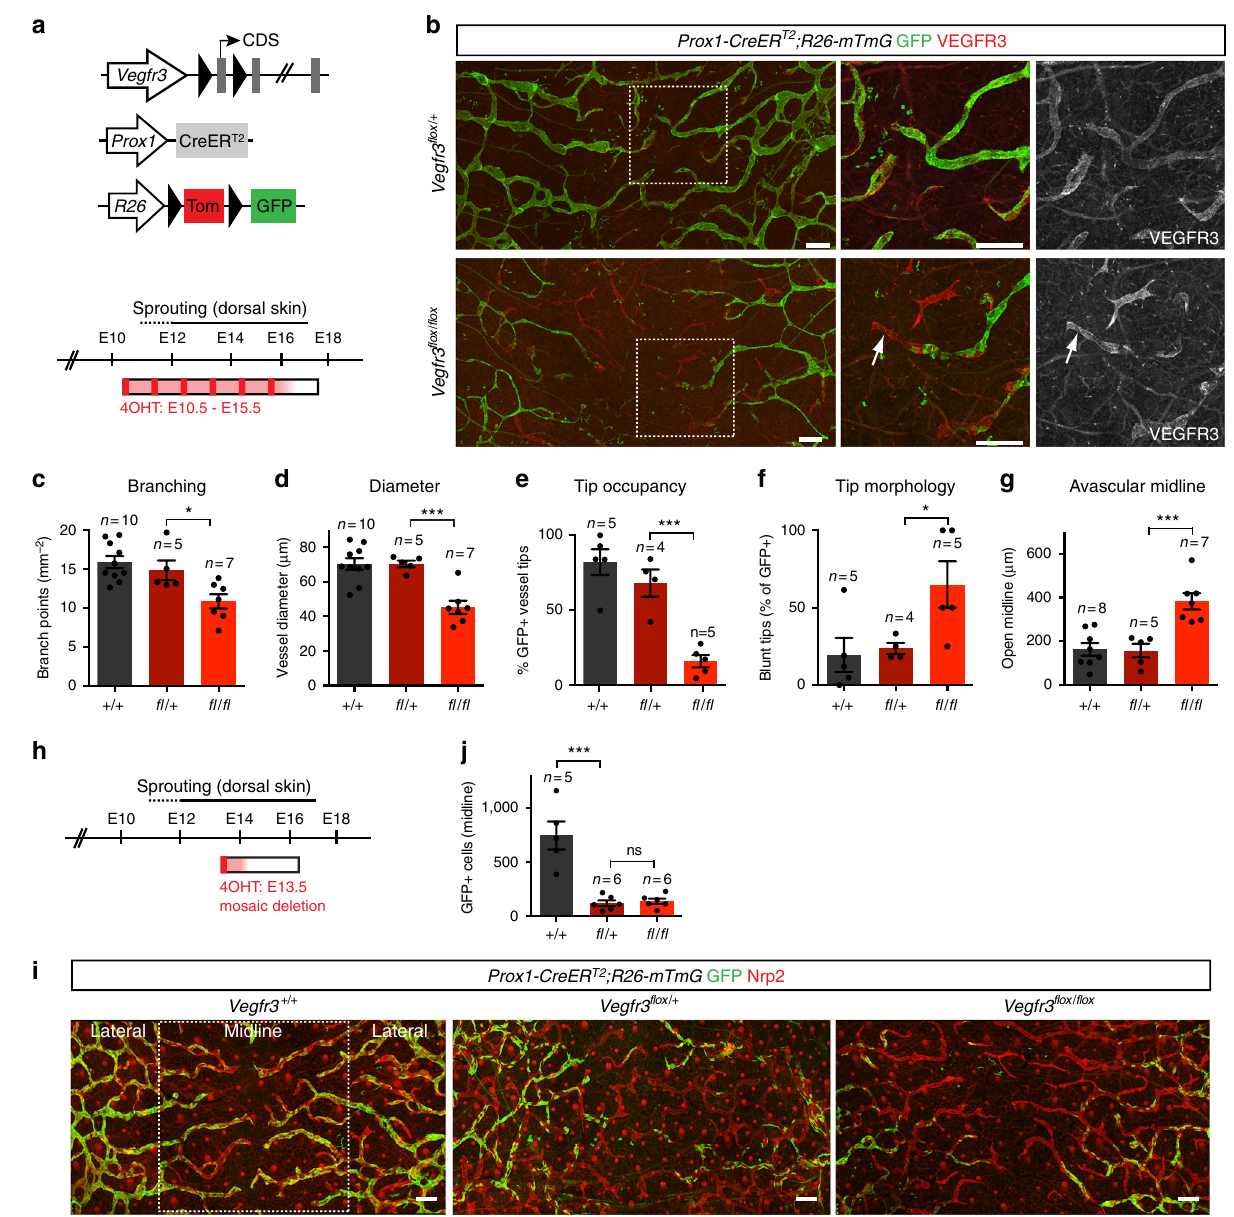
Fig. 1 VEGFR3 is indispensable for tip cell function during embryonic dermal lymphatic vessel sprouting. a Schematic of the genetic constructs and 4-OHT administration schedule (Cre induction, red (6 × 1 mg); estimated effective period (24 h), light red). The timing of dermal lymphatic vessel formation in the dorsal skin is indicated. b Whole-mount immuno fl uorescence of E17.5 Vegfr3 fl ox ; R26-mTmG ; Prox1-CreER T2 skin. Boxed areas are magni fi ed and single channel images for VEGFR3 staining are shown. Note ef fi cient depletion of VEGFR3 in the Cre-targeted (GFP + ) LECs and the presence of non-targeted cells at the tips of hypoplastic vessel sprouts (arrows) in the mutant ( fl ox/ fl ox ) skin. c – g Quanti fi cation of dermal lymphatic vessel parameters in E17.5 Vegfr3 fl ox ;R26-mTmG;Prox1-CreER T2 embryos. Bars represent mean ( n = 4 – 10 embryos, as indicated) ± s.e.m. h , i Whole-mount analysis of E16.5 skin after mosaic deletion of one ( fl ox/ + ) or two ( fl ox/ fl ox ) Vegfr3 alleles by a single 4-OHT (1 mg) administration at E13.5. j Quanti fi cation of Cre-targeted (GFP + ) LECs at the dorsal midline (area depicted in i ). Bars represent mean ( n = 5 – 6 embryos, as indicated) ± s.e.m. * P < 0.05, *** P < 0.001. Two-tailed unpaired Student ’ s t test ( c – g , j ). Scale bars: 200 µ m ( b , i ). ns: not signi fi